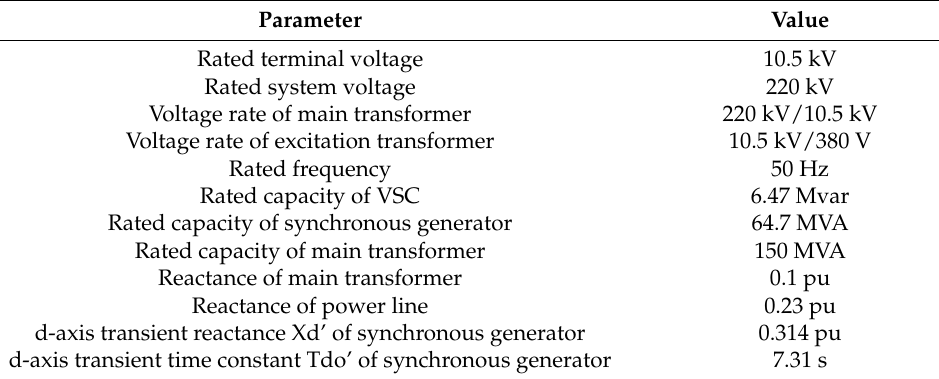
Figure 8. Structure of LOEC + AAL controller. Table 2. Parameters of simulation experiment.